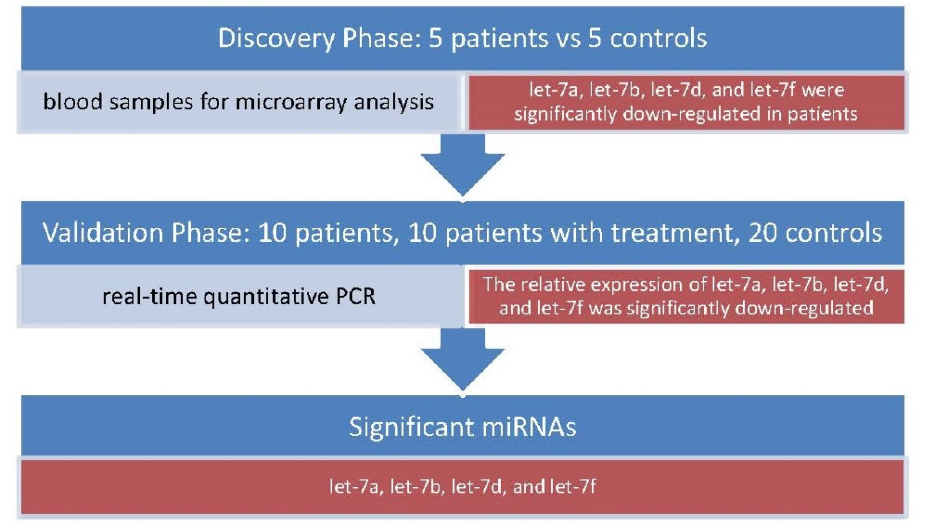
Figure 1. Figure 1. Let-7a, let-7b, let-7d, and let-7f were discovered to be miRNA biomarkers of anti-NMDAR encephalitis.